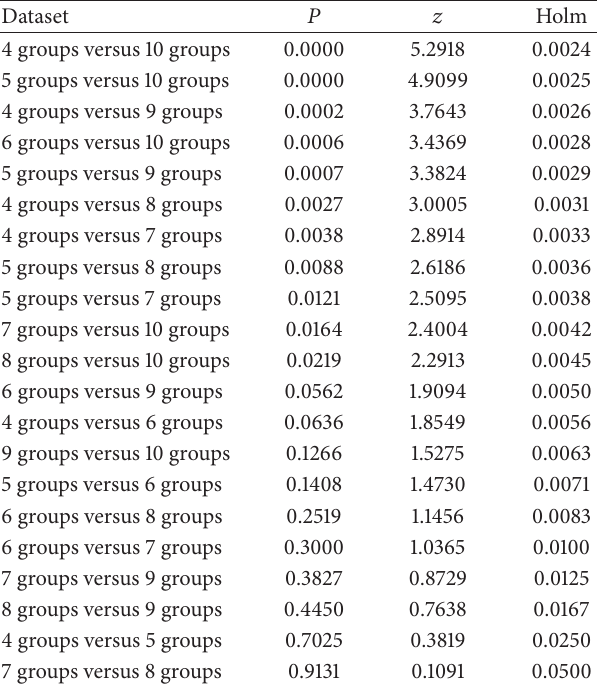
Table 11: Holm procedure on the effect of number of groups.